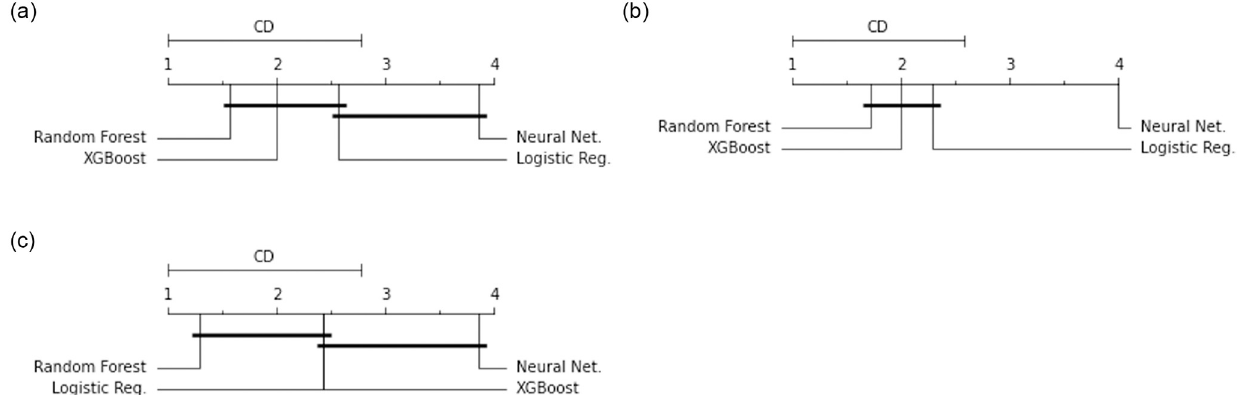
Fig 15. Critical difference diagram for ensemble models by comparing the four classifiers on different combinations of features; (a) Balanced Accuracy scores with α = 0.05, the critical difference is 1.77; (b) F1 with α = 0.1, the critical difference is 1.58; (c) AUC with α = 0.05, the critical difference is 1.77. Groups of classifiers not significantly different are